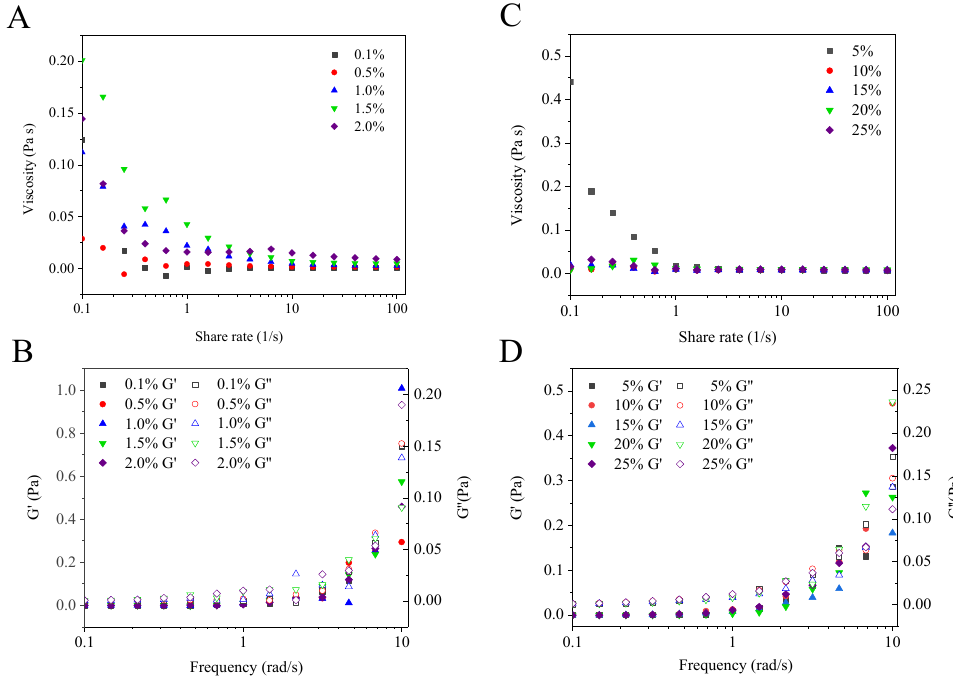
Figure 5. Apparent viscosity ( A ), storage modulus and loss modulus ( B ) of Pickering emulsions with different Z-R/P 2:1 particle concentrations. Apparent viscosity ( C ), storage modulus and loss modulus ( D ) of Pickering emulsions with different oil phase volume fractions.